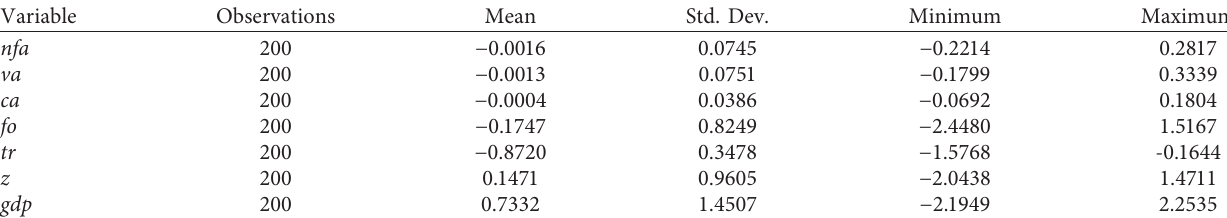
Table 2: Descriptive statistical